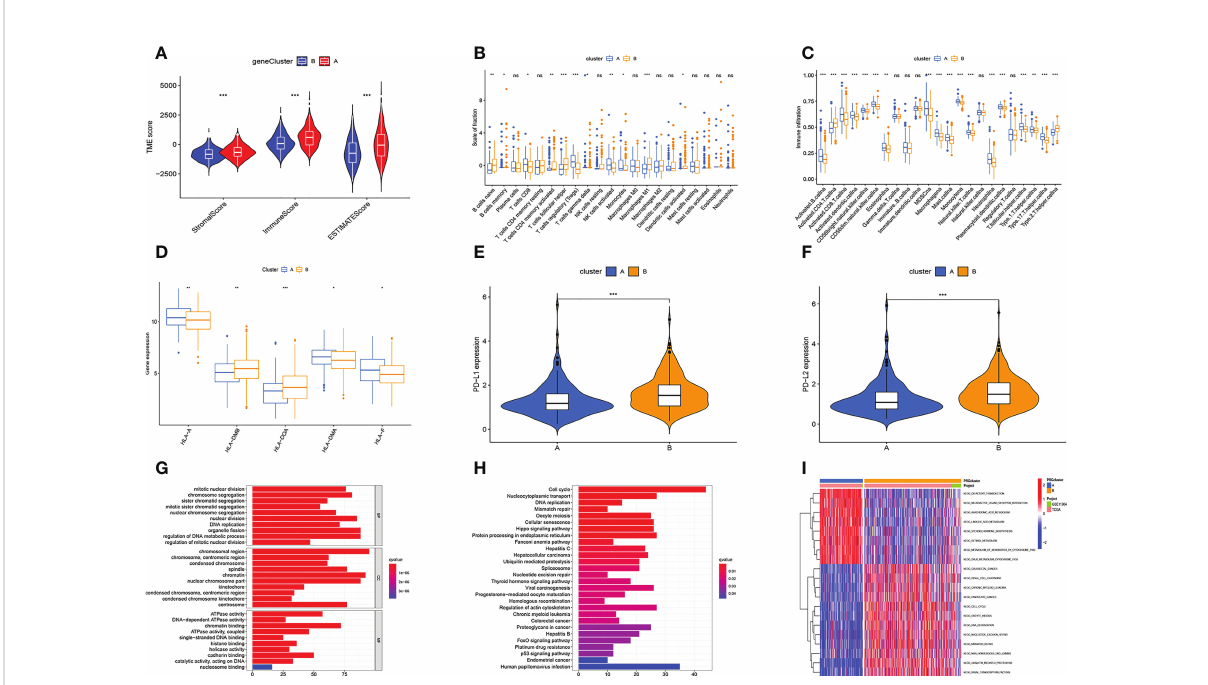
FIGURE 2 Multi-omics analysis based on senescence cluster. (A) TME analysis. Subtype A has a higher TME score. (B, C) Differences in immune cell in fi ltration levels. (D) Differences in HLA-related gene expression levels. (E, F) The PD-L1 and PD-L2 genes of subtype B are highly expressed. (G, H) The GO (G) and KEGG (H) enrichment analysis. (I) Differential KEGG enriched pathways between the two subtypes. Adjusted p-values were shown as ns, not signi fi cant; *p < 0.05; **p < 0.01; ***p <